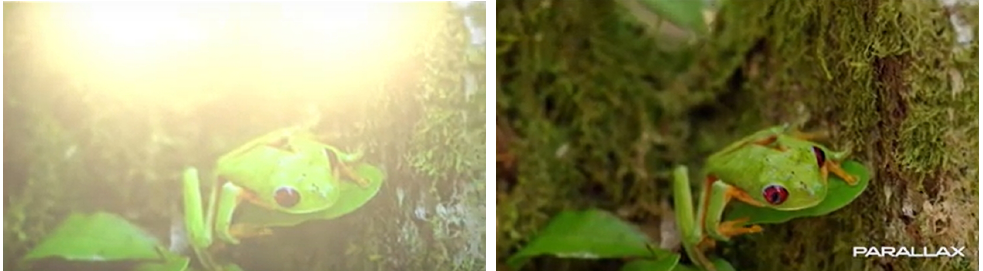
Figure 2. The lamp light affects the clarity of the projection screen. Reprinted with permission from ref. [26]. Accessed on 22 November 2021. Tsvetkova Darina.